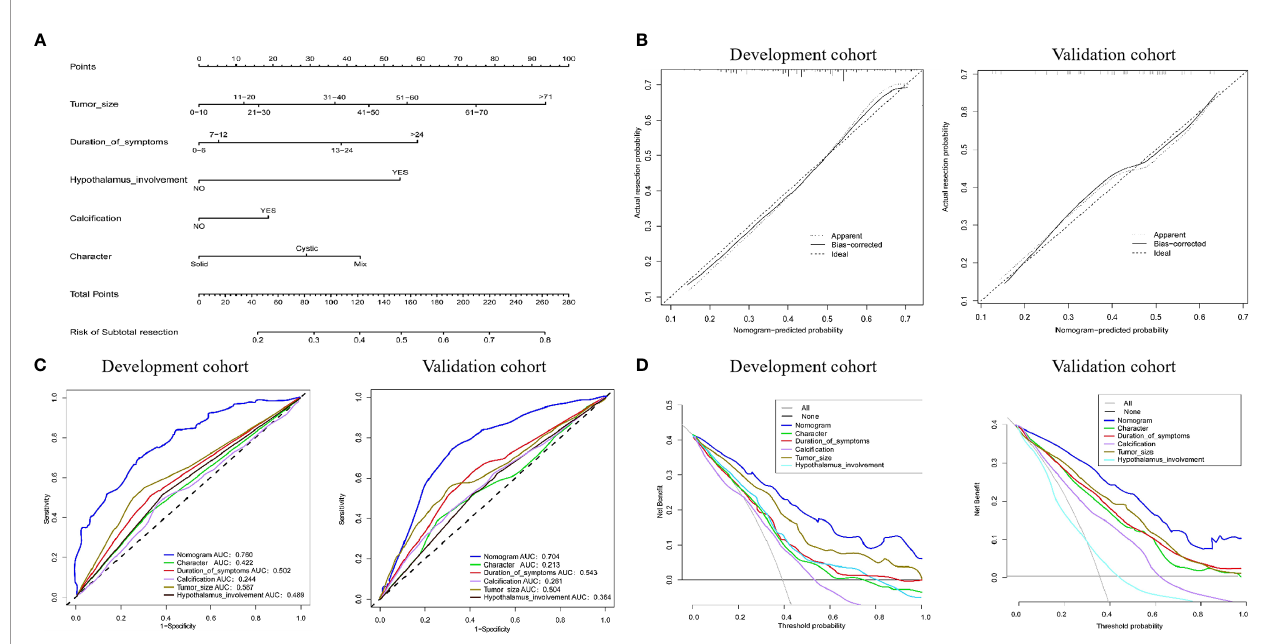
FIGURE 5 | (A) Nomogram for predicting the extent of resection. For each variable, a verticle line was drawn to the upward point line and the total score of 6 variables could be obtained to calculate the risk of subtotal resection. (B) Calibration curves for development and validation cohort. (C) The ROC curves of the nomogram, tumor size, duration of symptoms, hypothalamus involvement, calci fi cation, character and combined nomogram in the development and validation cohort. (D) The decision curve analysis of the nomogram. The Y-axis represents the net bene fi t. The larger net bene fi t means a patient can obtain the more bene fi t of the model.